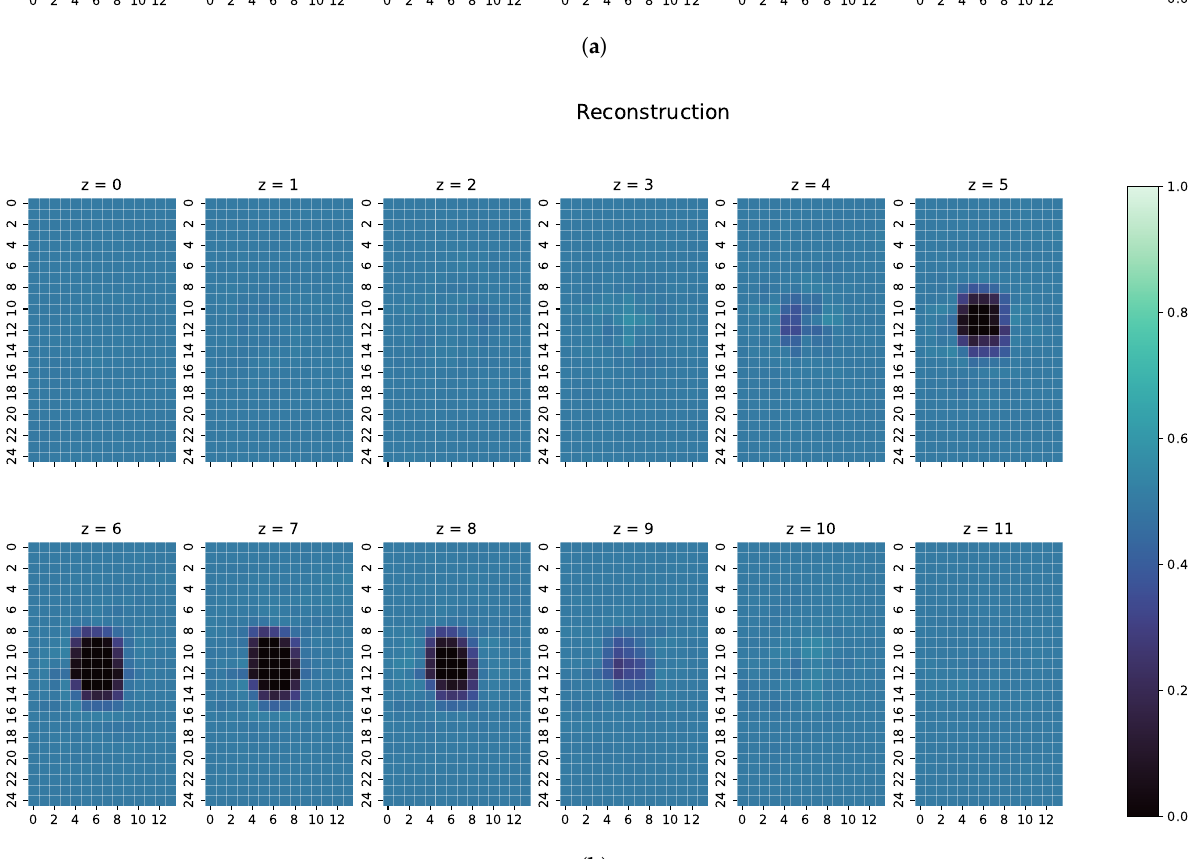
Figure 7. ( a ) Original conductivity distribution for case 1 with two objects overlapping each other in the centre of the body. ( b ) Reconstruction of the conductivity distribution of case 1, as shown in ( a